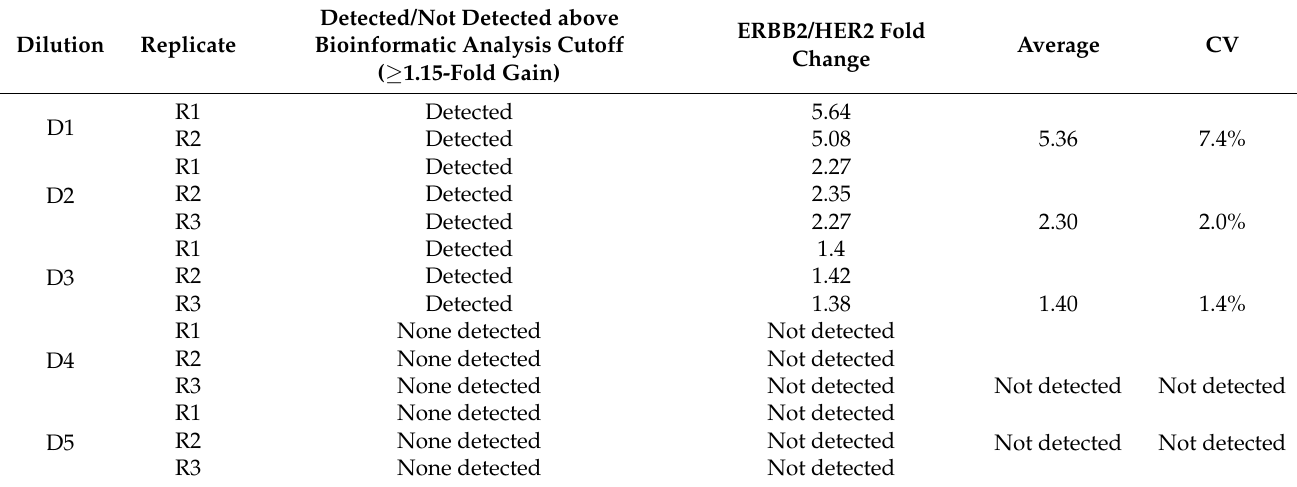
Table 2. Analytic sensitivity for the CNA variant type.